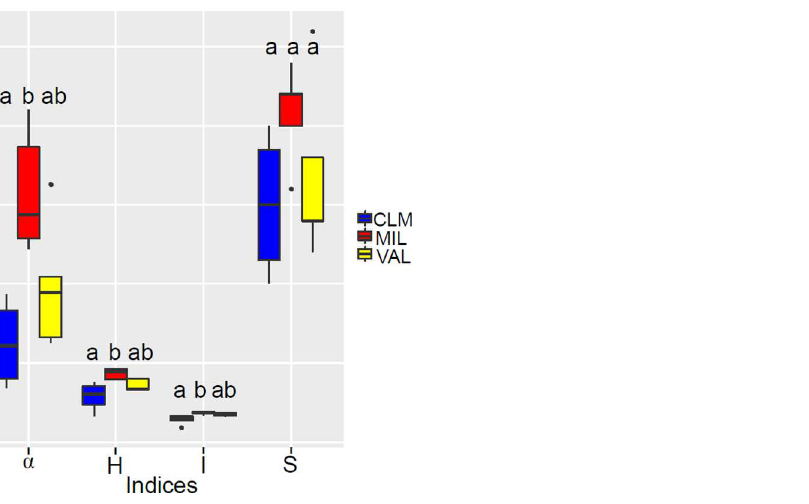
Fig 4. Box plot showing AMF diversity plots and the richness values of each site. The taxon richness (S), Shannondiversity (H), Simpson’s dominance (I), and Fisher’s alpha (alpha)values are reported. Boxplots with the same letter are not significantly different (p > 0.05), accordingto the non-parametric Nemenyi– Damico–Wolfe–Dunn post hoc test. CLM, Bassa di Colombart;MIL, Millefonts; VAL, Valcavera.